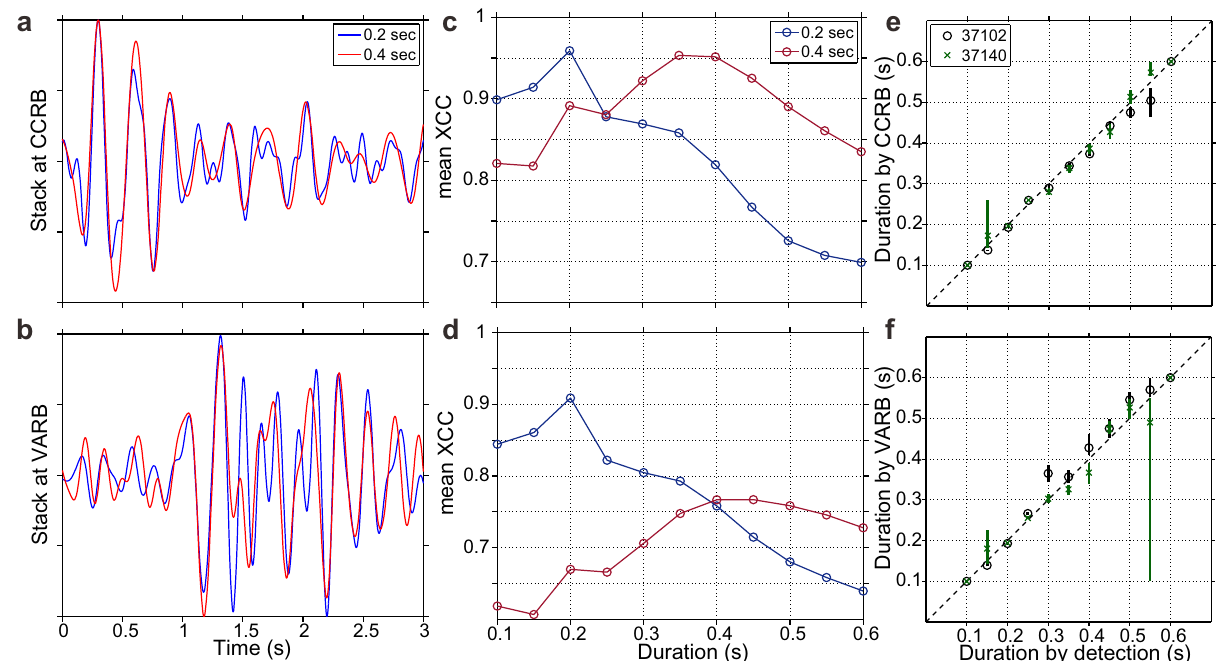
Fig. 4 | Validating durations of low-frequency earthquakes at independent datasets.a , b Waveformsfromstacking0.2-sec(blue)and0.4-sec(red)detections (component E) at station CCRB and VARB: stations that were not used in the detection. c , d Mean cross-correlation coef fi cients (XCCs) between the three- component stacks and different-duration synthetic templates at station CCRB and VARB, respectively. At both stations, the 0.2-sec stack best matches the 0.2-sec